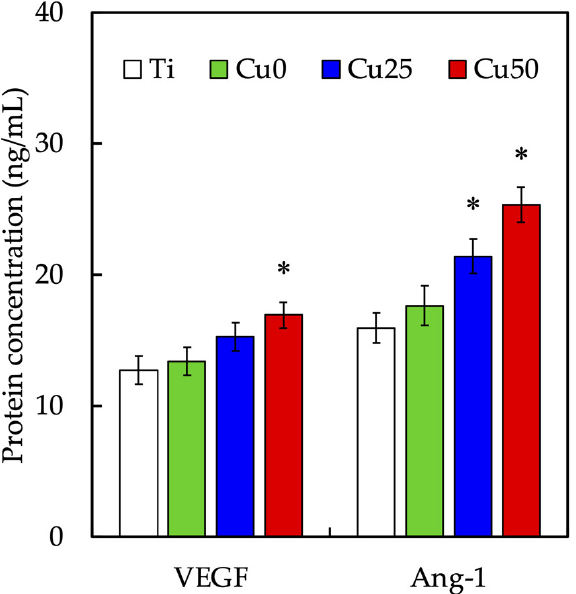
Figure 9. Angiogenic-related differentiation marker of VEGF activity and Ang-1 expression of HUVEC cultured on different TiPCu scaffolds at 3 days. * indicates a significant difference ( p < 0.05) from the Ti group. Data are presented as mean ± SEM, n = 6 for each group.